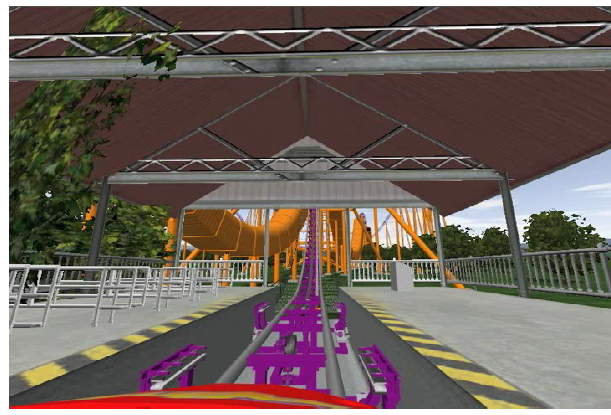
Figure 1 Screenshot of the rollercoaster